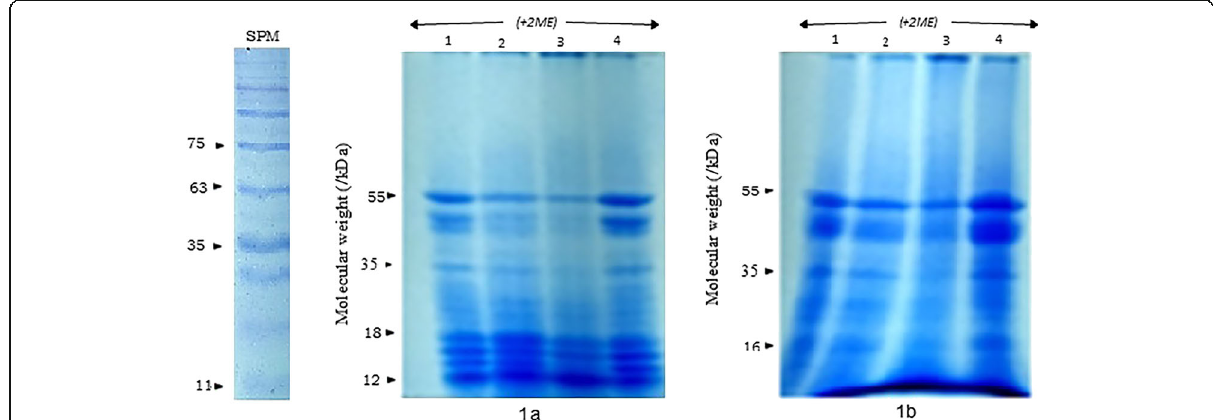
Fig. 1 a SDS-polyacrylamide gel electrophoresis of total seed protein extracts of cotton lines of G.hirsutum under reducing conditions (Tracks 1, 2, 3, 4 represent cotton lines ‘ F-2228 ’ , ‘ F-2383 ’ , ‘ LH-2108 ’ and ‘ LH-2076 ’ , respectively). ‘ +2ME ’ stands for presence of ‘ 2- Mercaptoethanol ’ . ‘ SPM ’ stands for Standard Protein Markers. b SDS-polyacrylamide gel electrophoresis of total seed extracts of cotton lines of G. arboreum under reducing conditions (Tracks 1, 2, 3 and 4 represent the cotton lines ‘ LD-1019 ’ , LD-949 ’ , LD-327 ’ , and ‘ FDK-124 ’ , respectively). ‘ +2ME ’ stands for the presence of ‘ 2-Mercaptoethanol ’